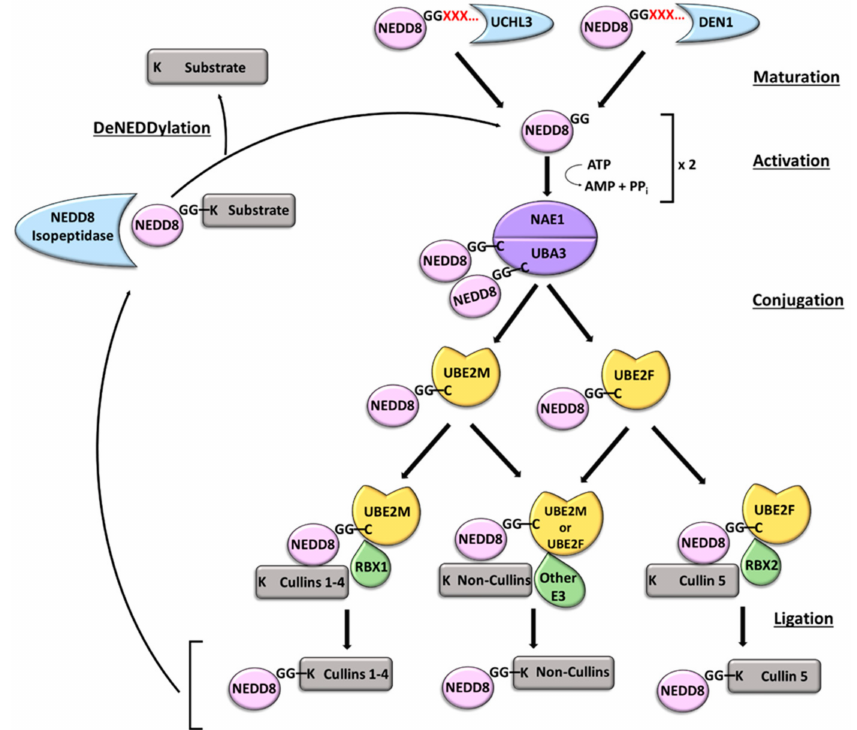
Figure 4. The NEDDylation catalytic cycle. A hydrolase, UCHL3 or DEN1, removes C-terminal amino acids of the NEDD8 precursor. The mature NEDD8 is activated in the ATP-dependent formation of a thioester bond with the UBA3 subunit of the E1 activating enzyme NAE. NEDD8 is transferred to an E2 conjugating enzyme, UBE2M or UBE2F, by a trans-thiolation reaction. A substrate specific E3 ligase facilitates ligation of NEDD8 to the substrate by binding to both the E2 enzyme and substrate. NEDDylation is reversed when a NEDD8 isopeptidase cleaves the NEDD8